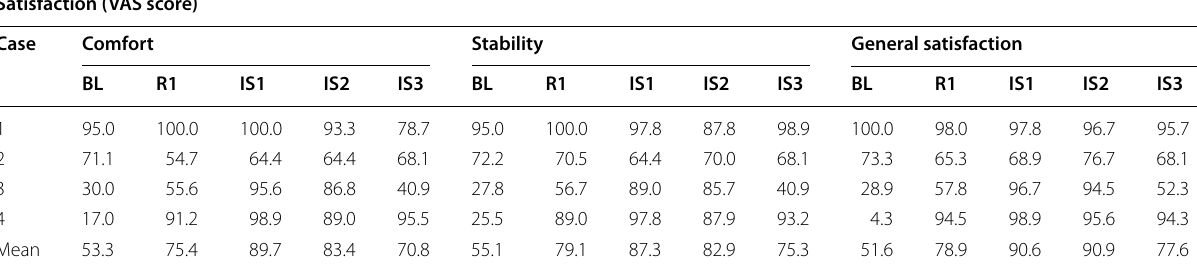
BL baseline, R1 3 months after insertion of RPD, IS1 3 months after insertion of implant-supported RPD, IS2 6 months after insertion of implant-supported RPD, IS3 12 months after insertion of implant-supported RPD, VAS visual analog scale